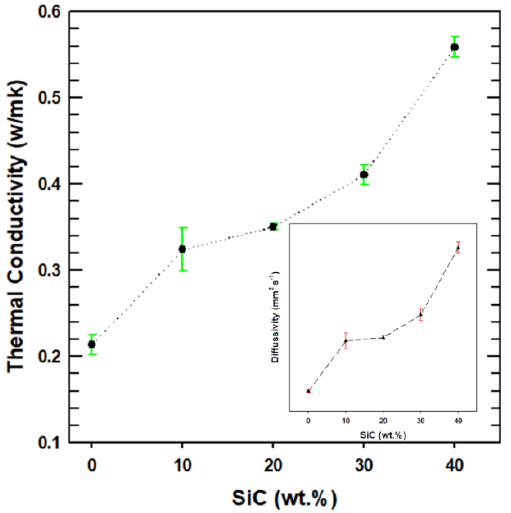
Figure 4. Thermal conductivity of the neat PBS and PBS composites.